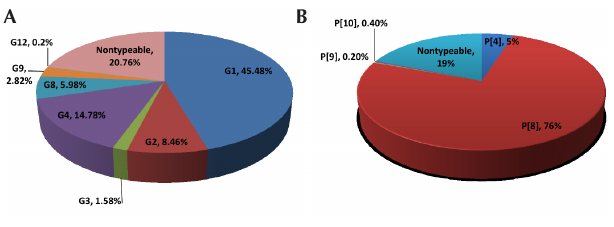
Figure 2. Distribution of Rotavirus Genotypes in Iran: (A) G Genotypes From 2001 to 2011; (B) P Genotypes From 2001 to 2008.